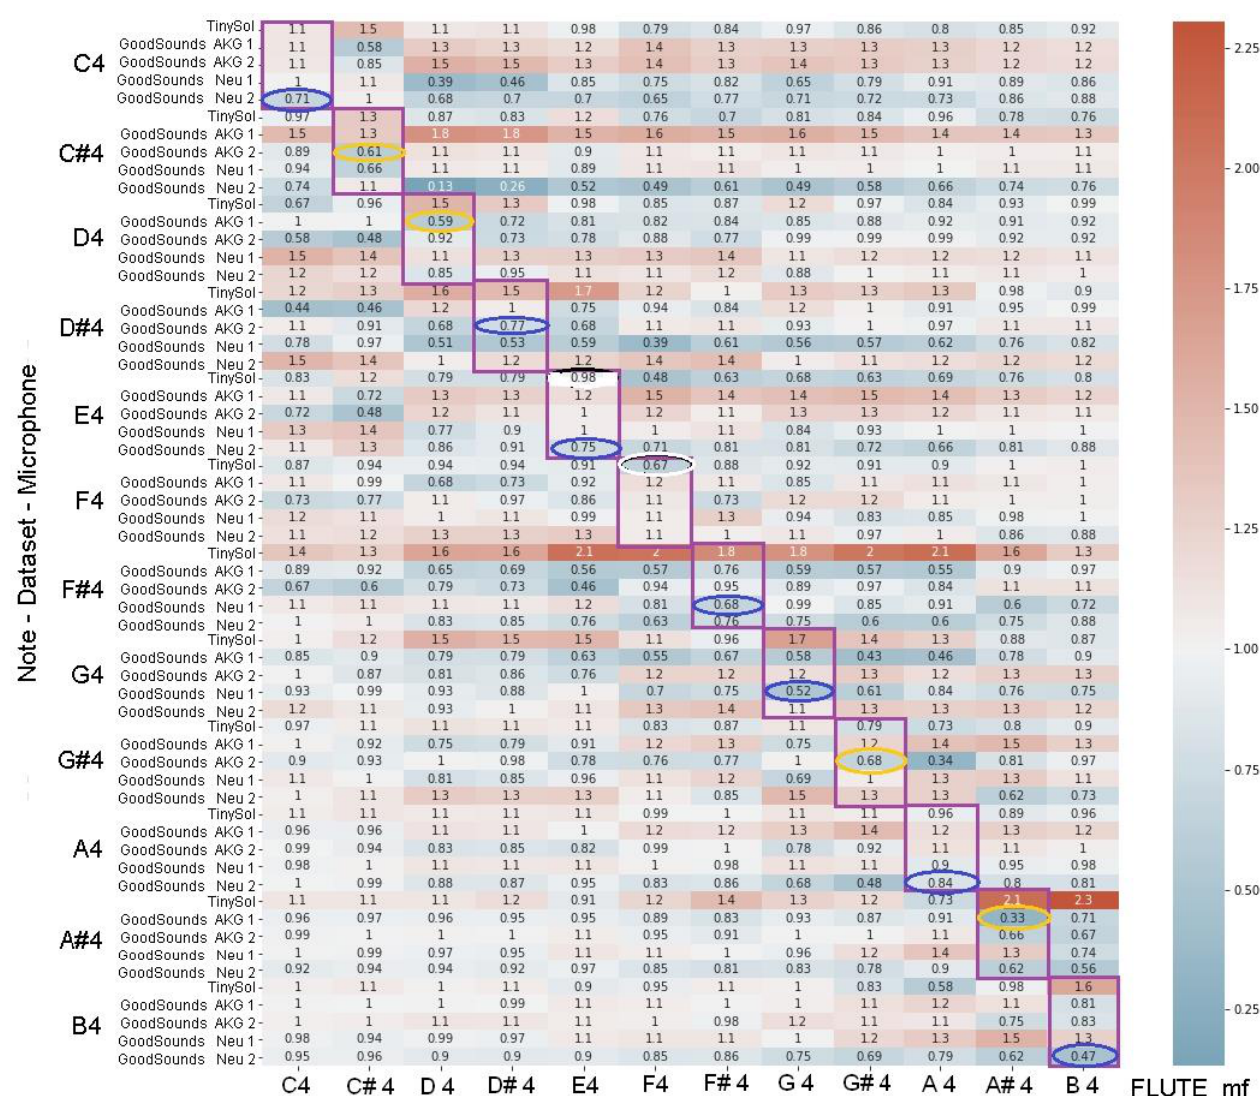
Figure 6. Patterned distance between musical sounds for Flute to reference sounds, according to several data sets. The circles of colors represent the shortest distance between the sound libraries.